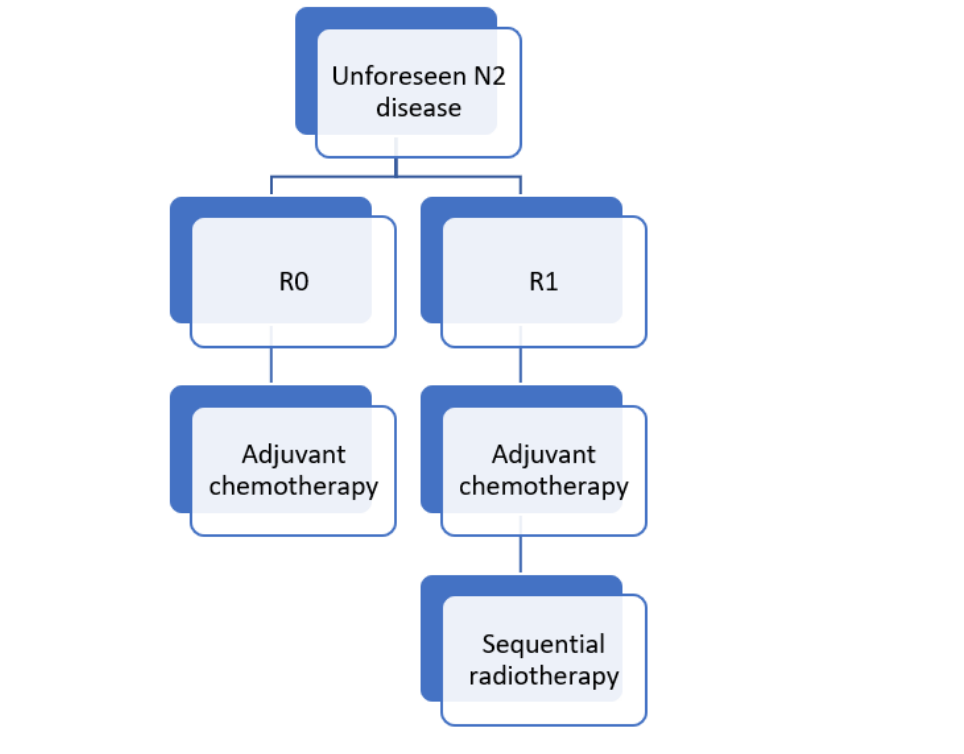
Figure 1. Current treatment algorithm at Antwerp University Hospital for unforeseen N2 disease. R0, complete resection; R1, incomplete resection.